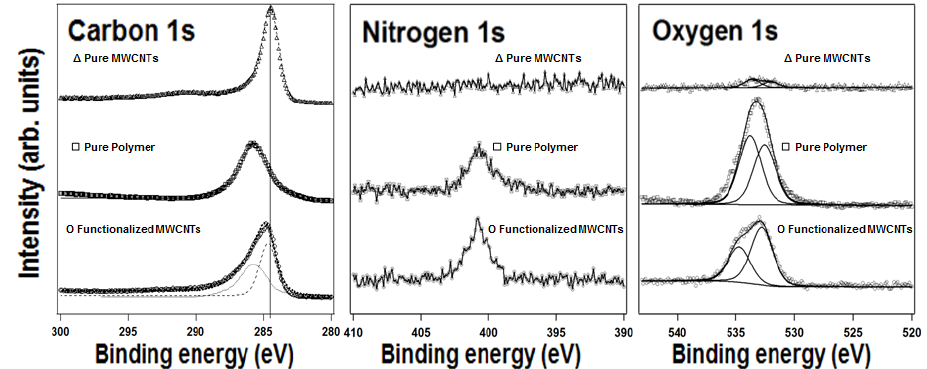
Figure 3. X-ray photoemission spectra of the C1s, N1s and O1s core level regions of MWCNTs functionalised with PK-Fu. Data and fitting lines are shown.